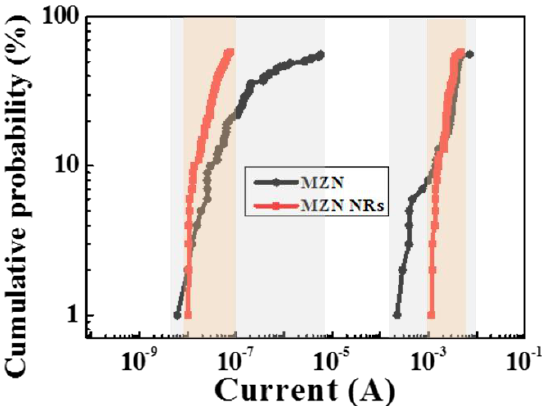
Figure 10. Current statistical distributions of: ( a ) Al/MZN/ITO device; and ( b ) Al/MZN NR/ITO device.